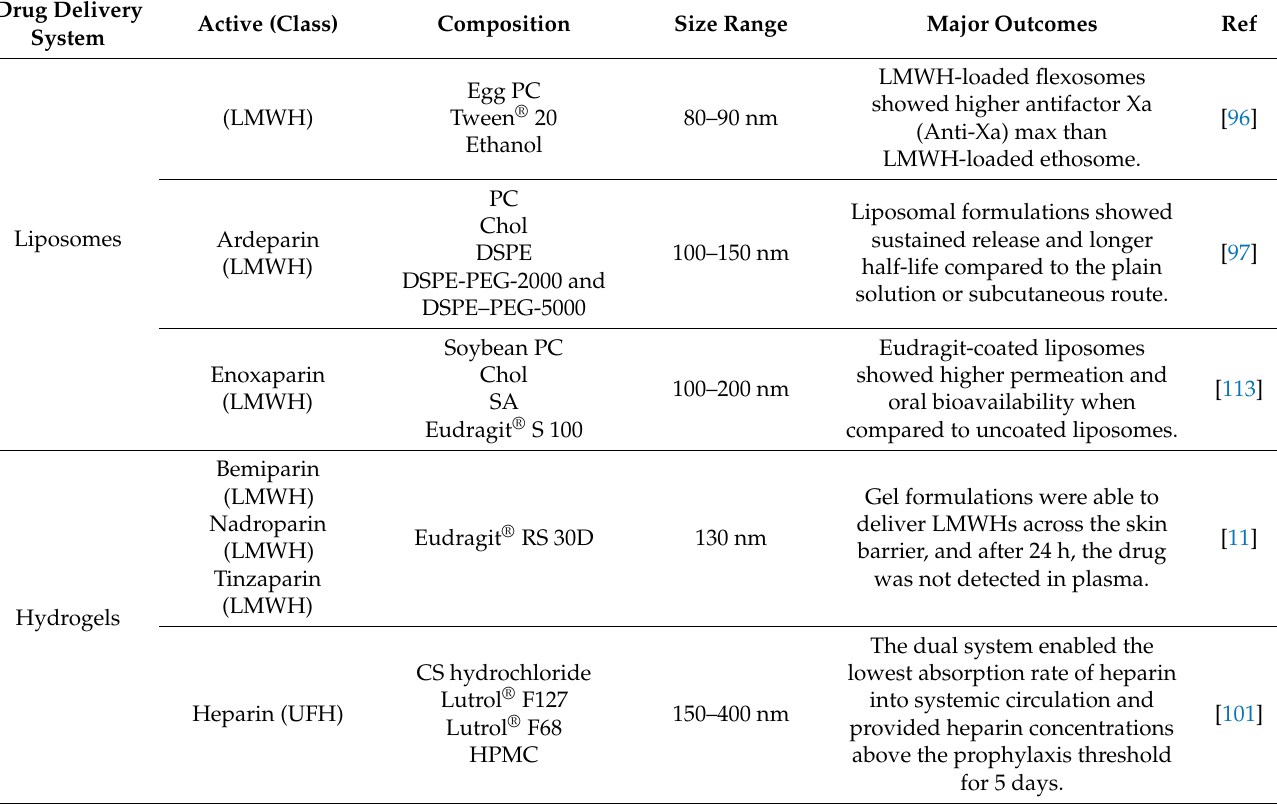
Table 3. Anticoagulant drug delivery systems for different routes of administration. Drug